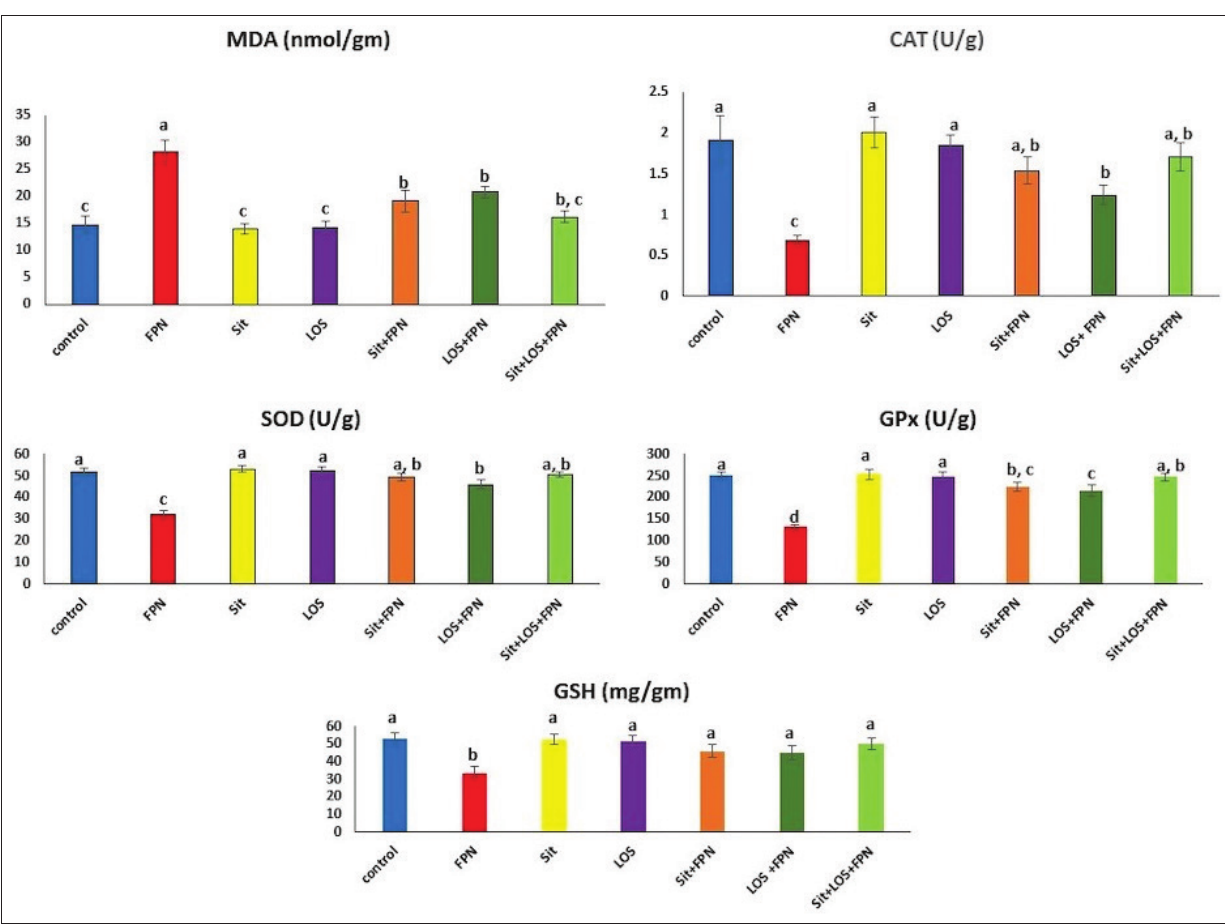
Figure-2: The effect of sitagliptin and losartan on hepatic tissue lipid peroxidation and activities of antioxidant enzymes in fipronil-intoxicated rats. Data are expressed as Mean±SEM (n=6). Means with different superscript letters (a-d) are significantly different at p≤0.05. FPN=Fipronil; Sit=Sitagliptin; LOS=Losartan; MDA=Malondialdehyde; CAT=Catalase; SOD=Superoxide dismutase; Gpx=Glutathione peroxidase; GSH=Reduced